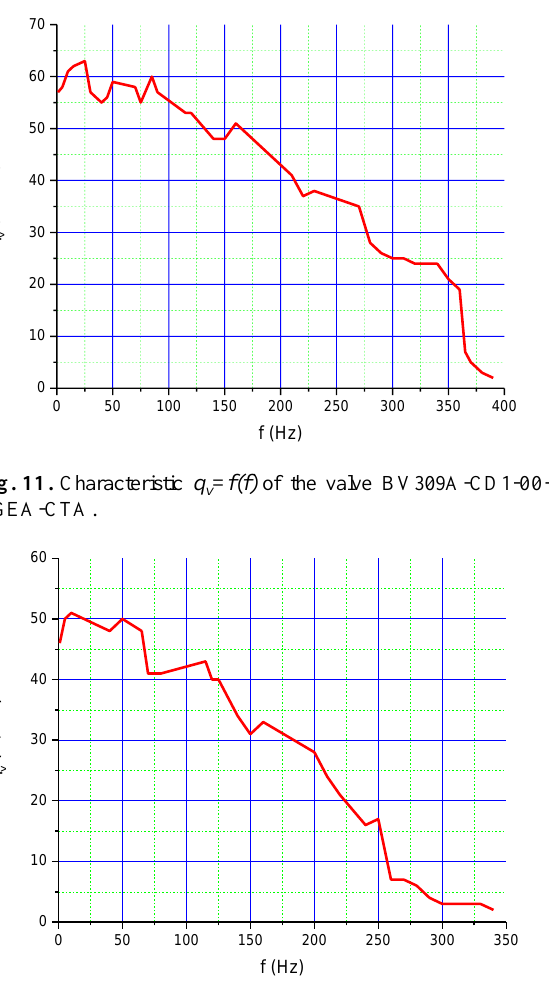
Fig. 12. Characteristic q